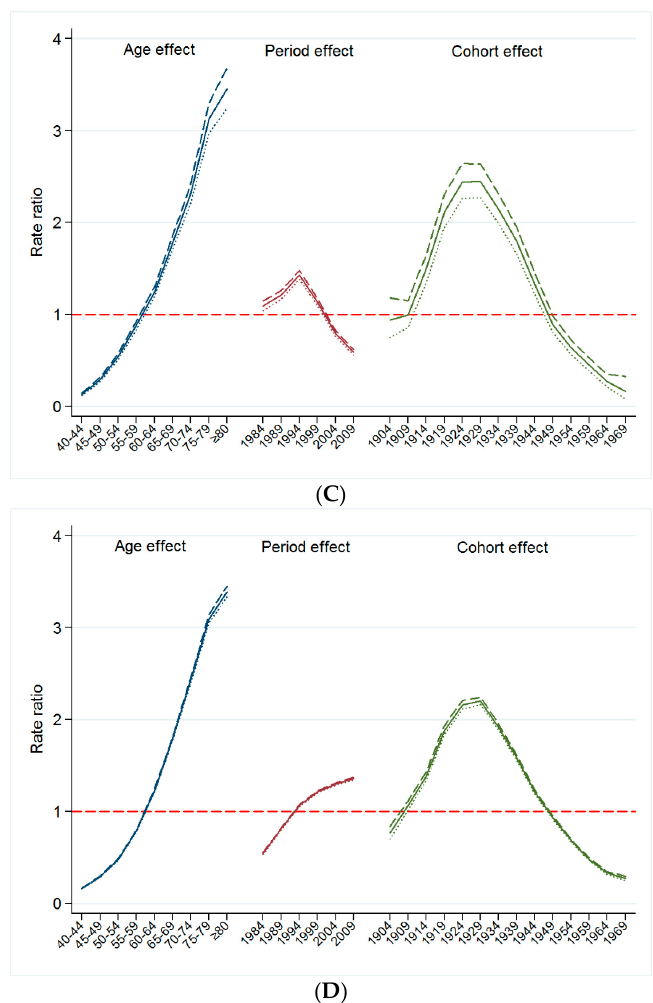
Figure 4. ( A ) Birth cohort effects on the oropharyngeal cancer mortality rate. Footnotes: The cohort effects on the oropharyngeal cancer mortality are estimated by a log-linear model using the intrinsic estimator (IE) method and expressed as risk ratios. The cohort effects and their 95% confidence intervals on the oropharyngeal cancer mortality represent as solid lines and dashed lines, respectively; ( B ) Birth cohort effects on the esophageal cancer mortality rate in Korean men. Footnotes: The cohort effects on the esophageal cancer mortality are estimated by a log-linear model using the intrinsic estimator (IE) method and expressed as risk ratios. The cohort effects and their 95% confidence intervals on the esophageal cancer mortality represent as solid lines and dashed lines, respectively; ( C ) Birth cohort effects on the laryngeal cancer mortality rate in Korean men. Footnotes: The cohort effects on the laryngeal cancer mortality are estimated by a log-linear model using the intrinsic estimator (IE) method and expressed as risk ratios. The cohort effects and their 95% confidence intervals on the laryngeal cancer mortality represent as solid lines and dashed lines, respectively; ( D ) Birth cohort effects on the lung cancer mortality rate in Korean men. Footnotes: The cohort effects on the lung cancer mortality are estimated by a log-linear model using the intrinsic estimator (IE) method and expressed as risk ratios. The cohort effects and their 95% confidence intervals on the lung cancer mortality represent as solid lines and dashed lines, respectively.